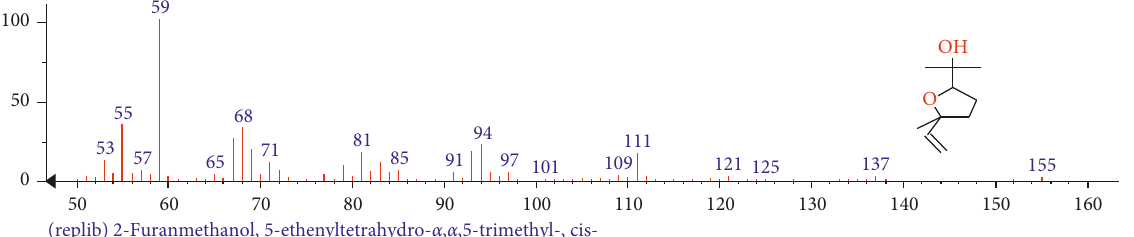
Figure 4: Mass spectrum of compound 2-furanmethanol, 5-ethenyltetrahydro- α,α ,5 trimethyl-, cis- of whole plant hexane fraction of Achillea wilhelmsii